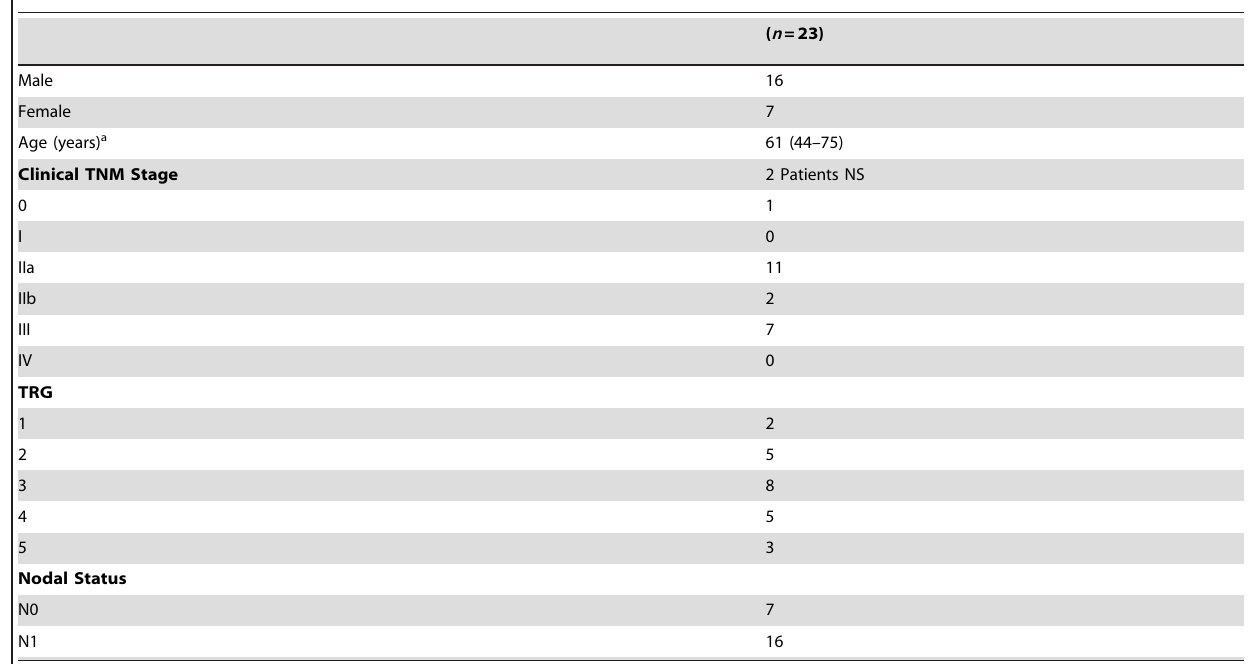
Table 1. Patient cohort